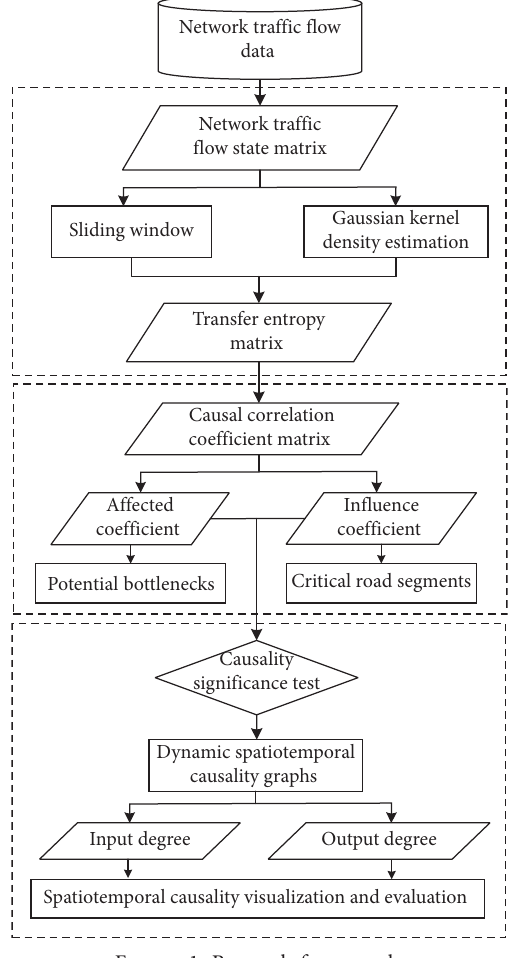
Figure 1: Research